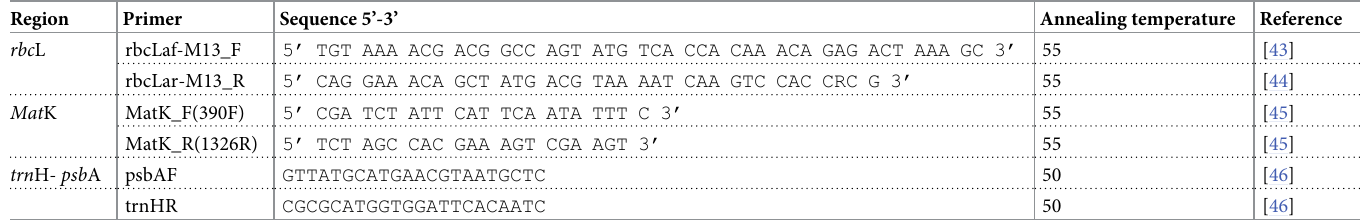
Table 1. Primers used for DNA barcoding